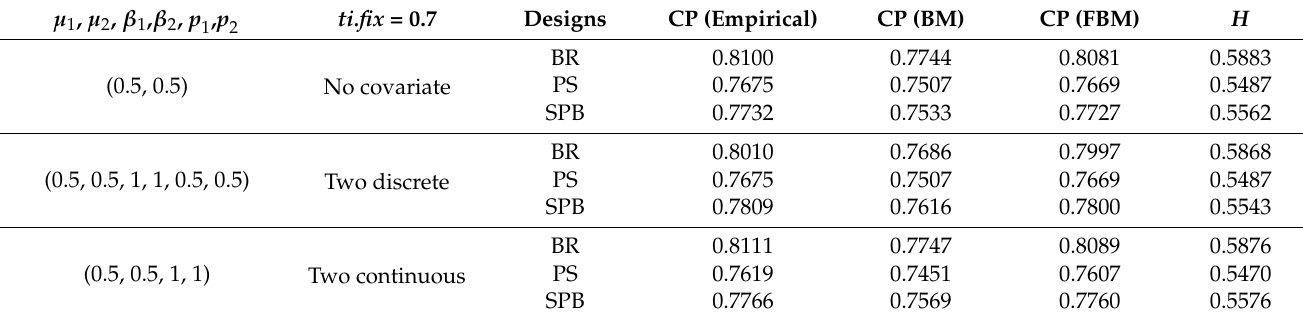
Table 6. CPs under misspecification scenarios: ε ’s ~increments of FBM, H = 0.9, drift = 1.5, ti.fix = 0.7.